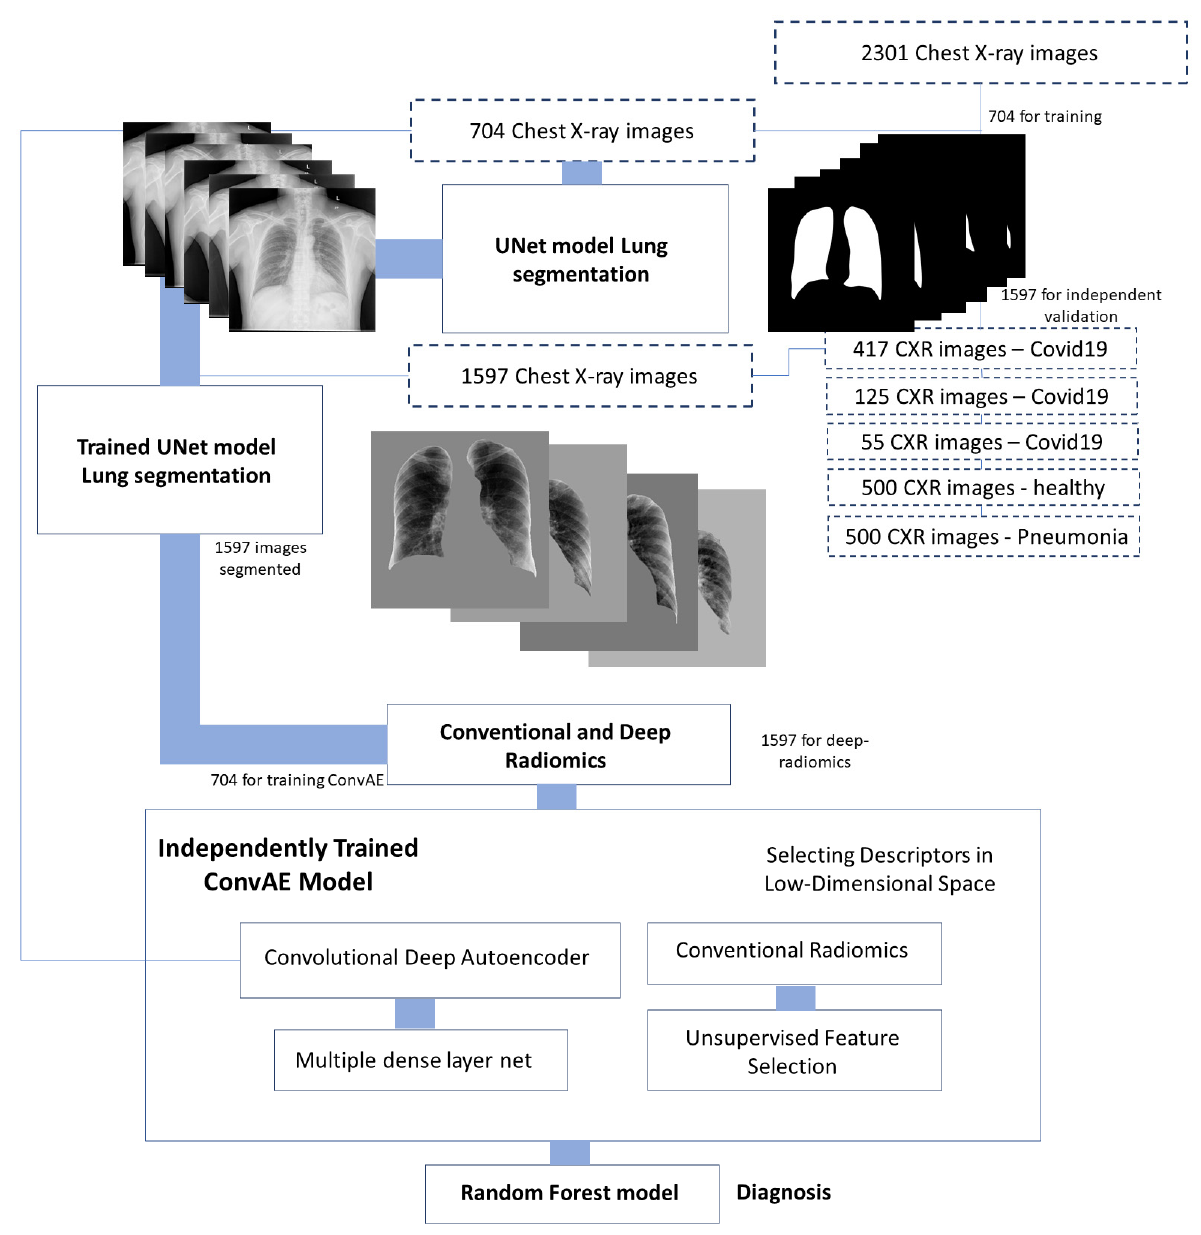
Figure 1. Schematic representing the proposed approach using ConvAE radiomics in low-dimensional space representation for diagnosis of COVID-19.